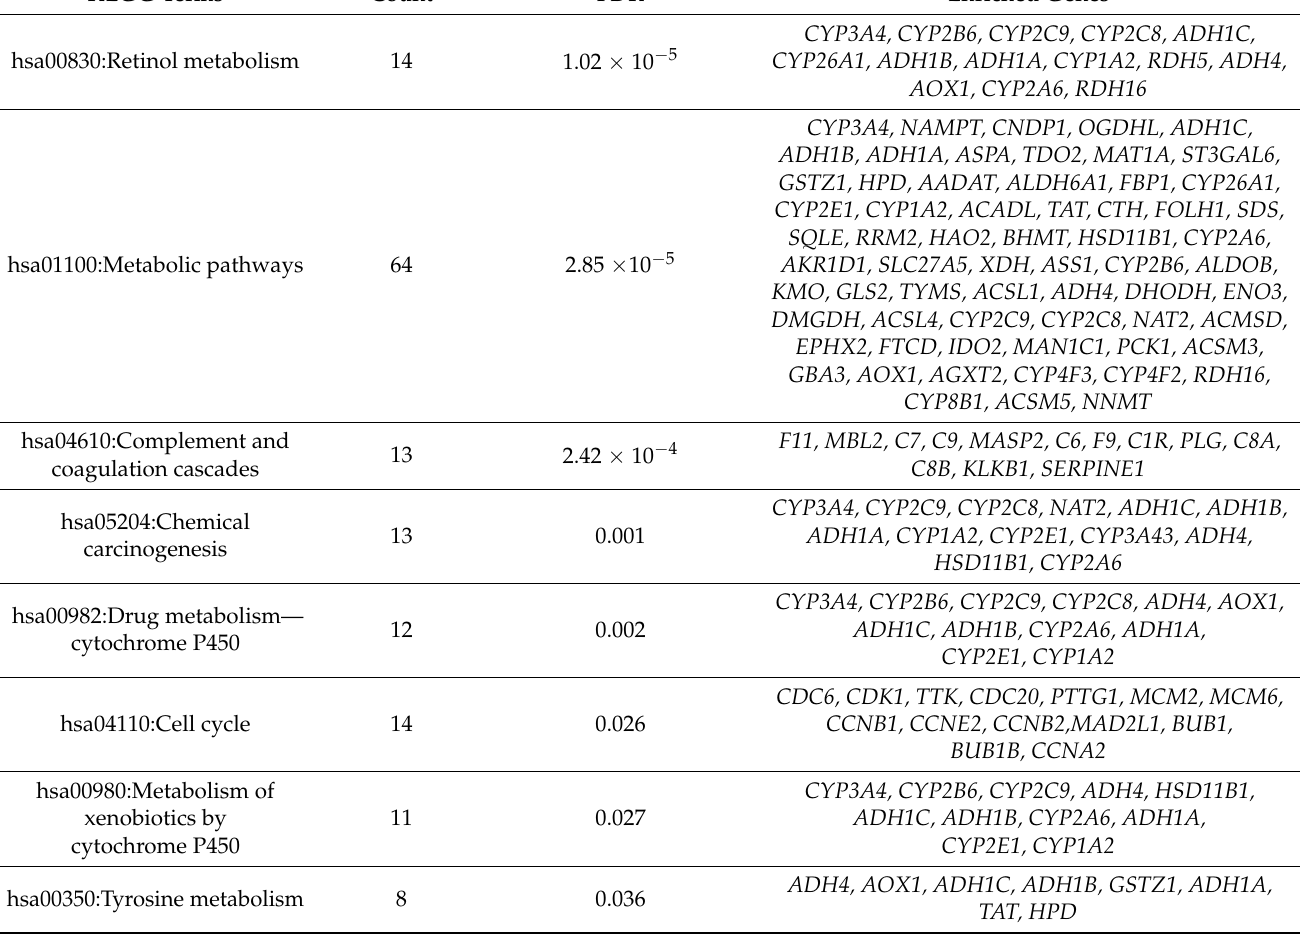
Table 4. The results of significantly enrich KEGG pathways of prognostic genes and their co-expressed deregulated genes. KEGG Terms Count FDR Enriched